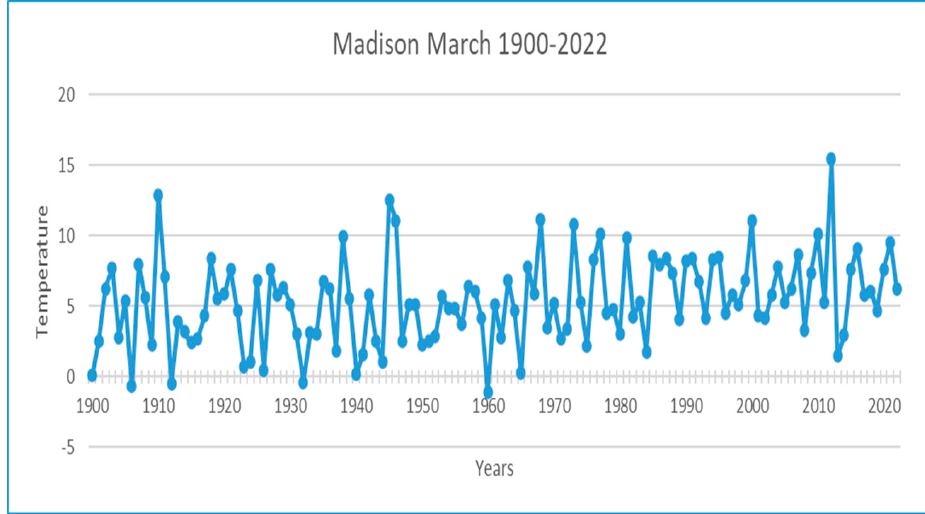
Figure 8. Maximum monthly temperature in Madison, Wisconsin, between 1900 and 2022. March 2012 was the warmest March since March 1910.